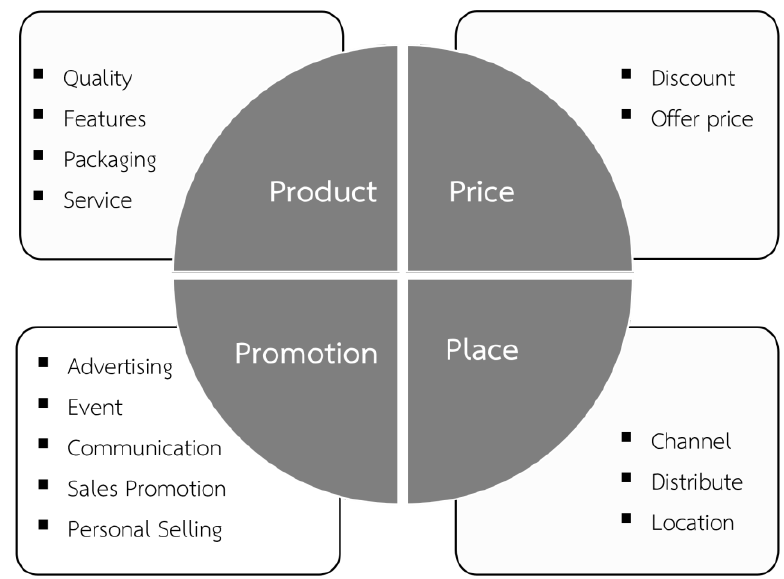
Figure 4. The marketing mix concept.